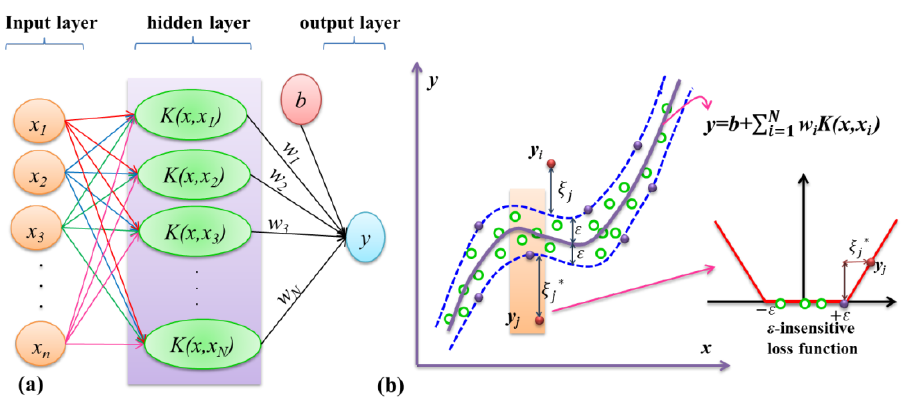
Figure 5. The SVR model: ( a ) structure; ( b ) predicted model [89].